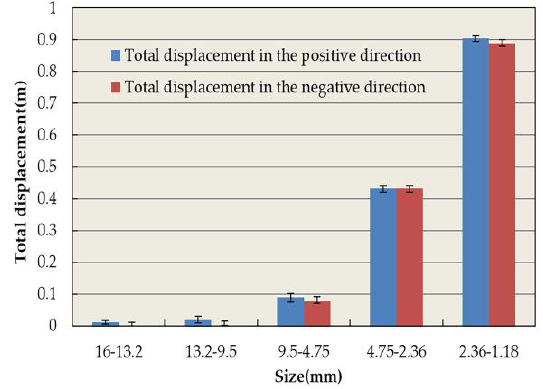
Figure 17. Total y-axis displacement of coarse aggregates.